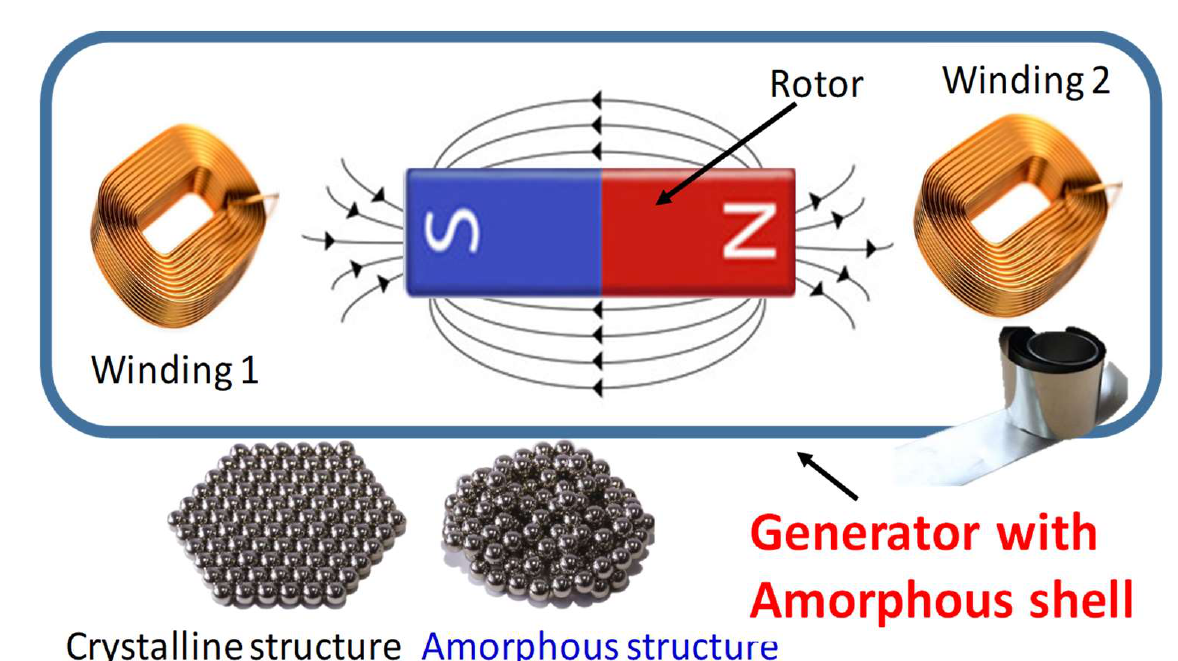
Figure 1. Single phase generator shell with amorphous alloy.